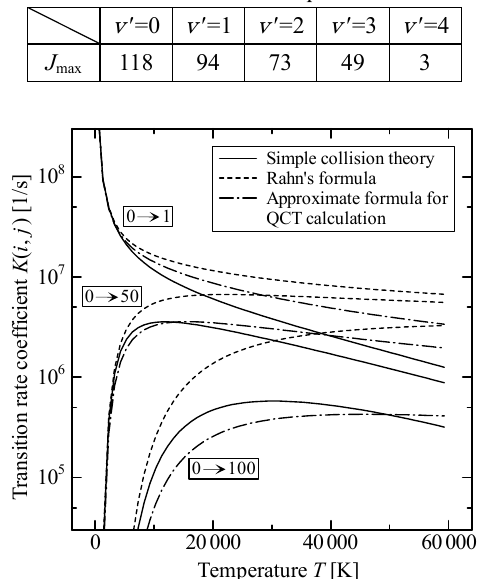
Table 1 Maximum rotational quantum number